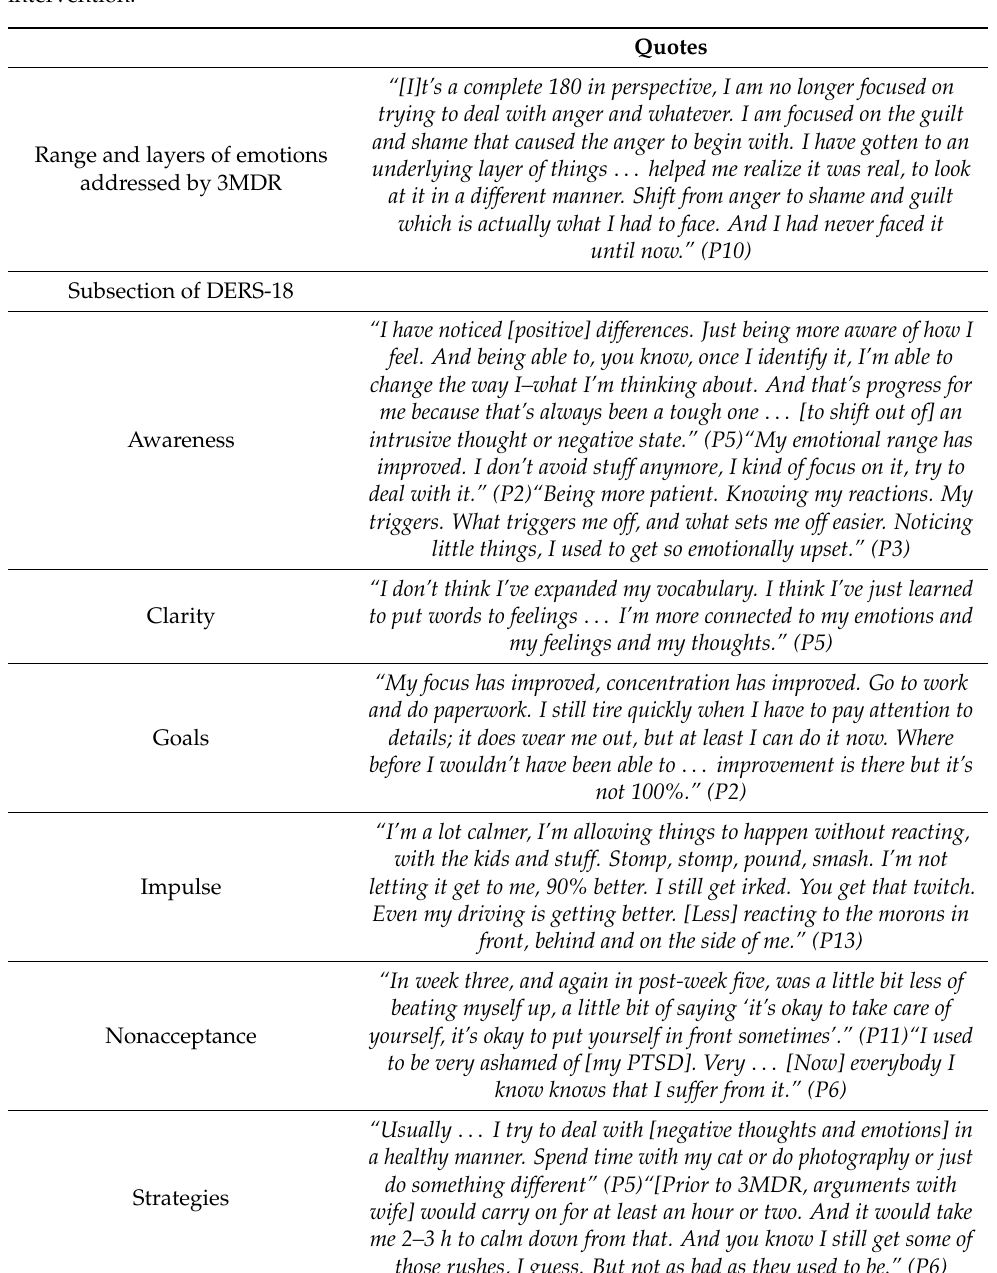
Table 2. Qualitative narrative analysis: participant quotes describing changes in ER following 3MDR